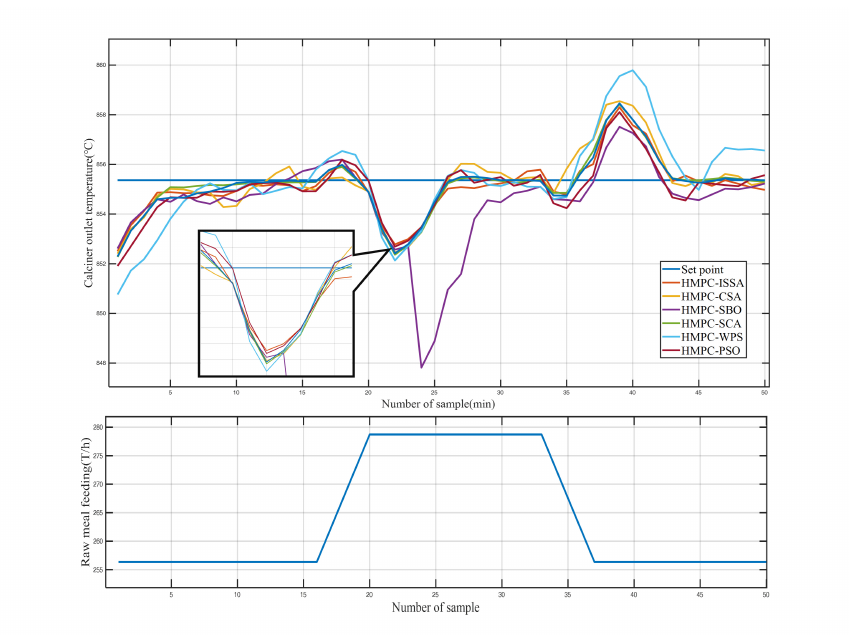
Figure 11. Controller stability verification with ISSA.